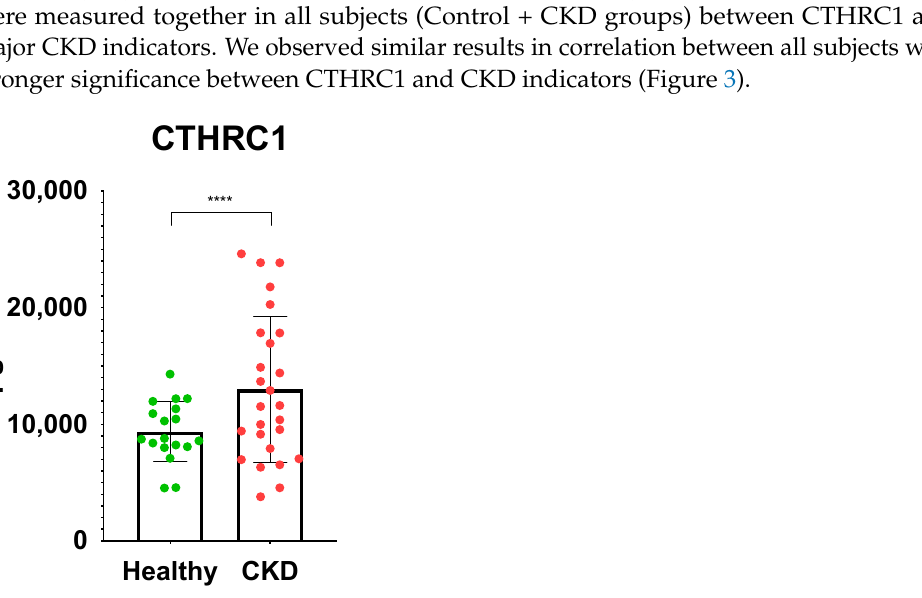
Figure 2 . Significant differences in CTHRC1 between control group and CKD patients. Unpaired two-tailed t -test was used to calculate the p values to define the significance. **** p ≤ 0.0001.